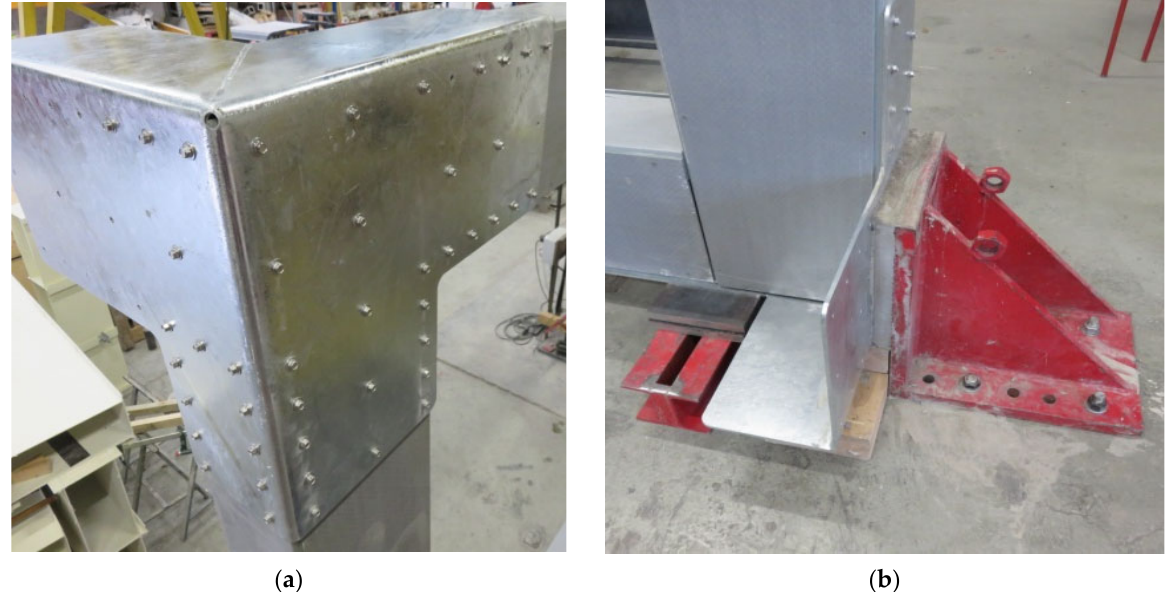
Figure 6. Test set ‐ up of the portal frame, specimen PF (measures in mm) .